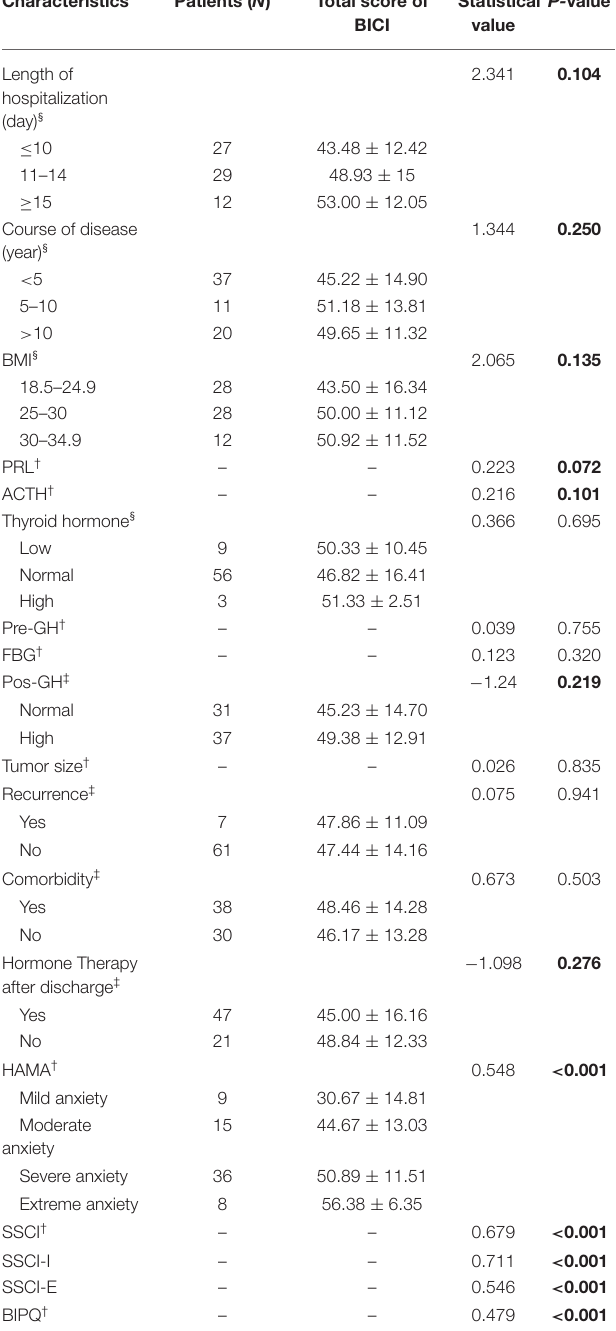
TABLE 2 | Univariate analysis of clinical and psychological characteristics of body image concern in patients with acromegaly. Characteristics